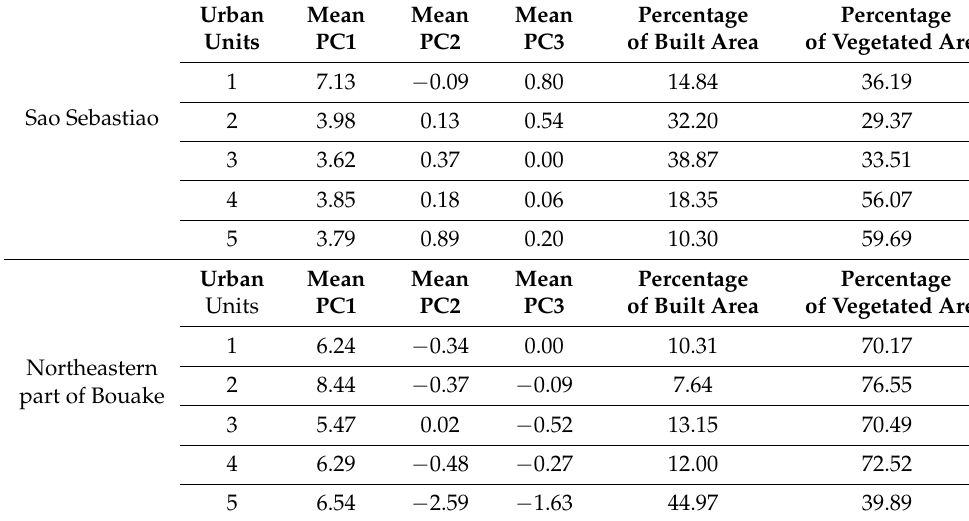
Table 4. Some metrics calculated for the urban units identified from texture using FOTOTEX on Pleiades images in Bouake and Brasilia (Sao Sebastiao). Correlations between the texture information represented by the mean of Principal Component PC 1, 2 and 3, and variables such as the percentage of built areas and vegetated areas are